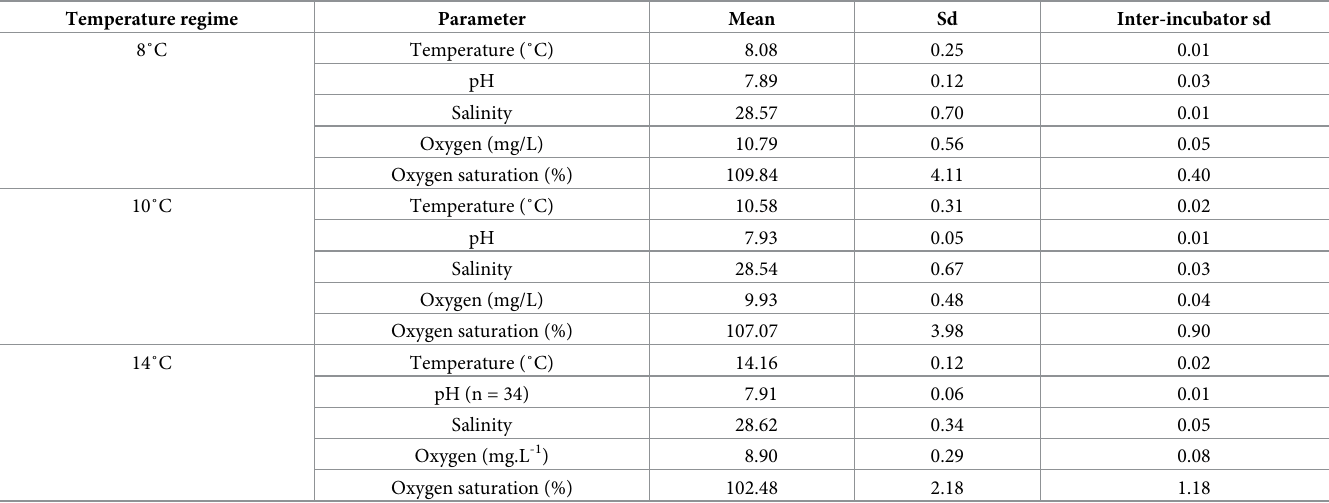
Table 1. Daily physical and chemical parameters followed along the experiment for each temperature regime. Sd: standard deviation. Temperature regime